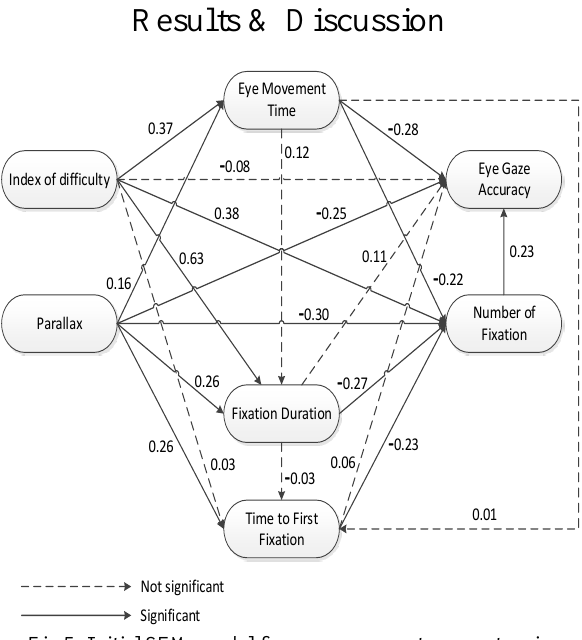
Fig.5. Initial SEM model for eye movement parameters in projection-based stereoscopic display.